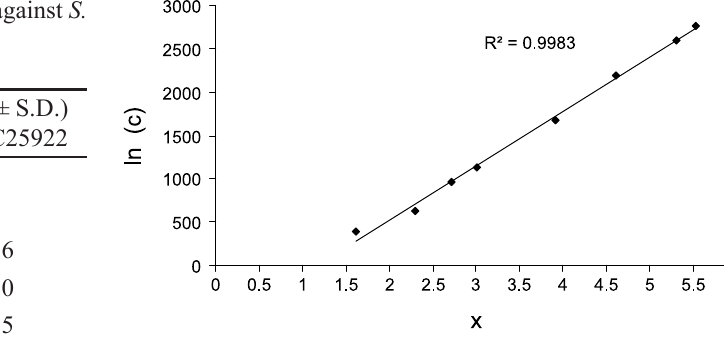
FIGURE 2 - x 2 vs. ln (c) plot of control (standard amoxicillin trihydrate) using S. aureus . x = zone of inhibition (mm); c = concentration of control samples (µg/mL)